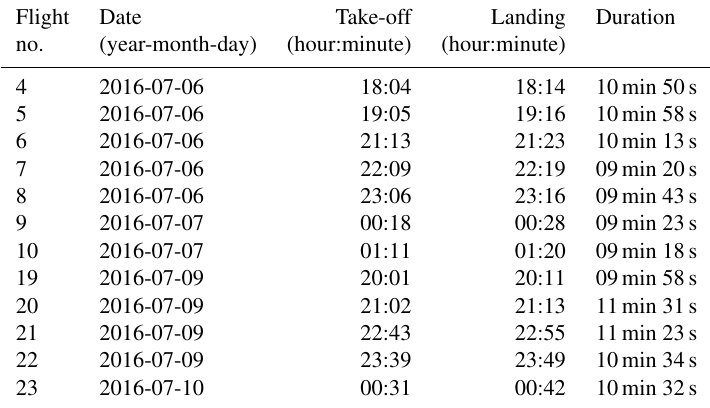
Table 2. Take-off and landing times